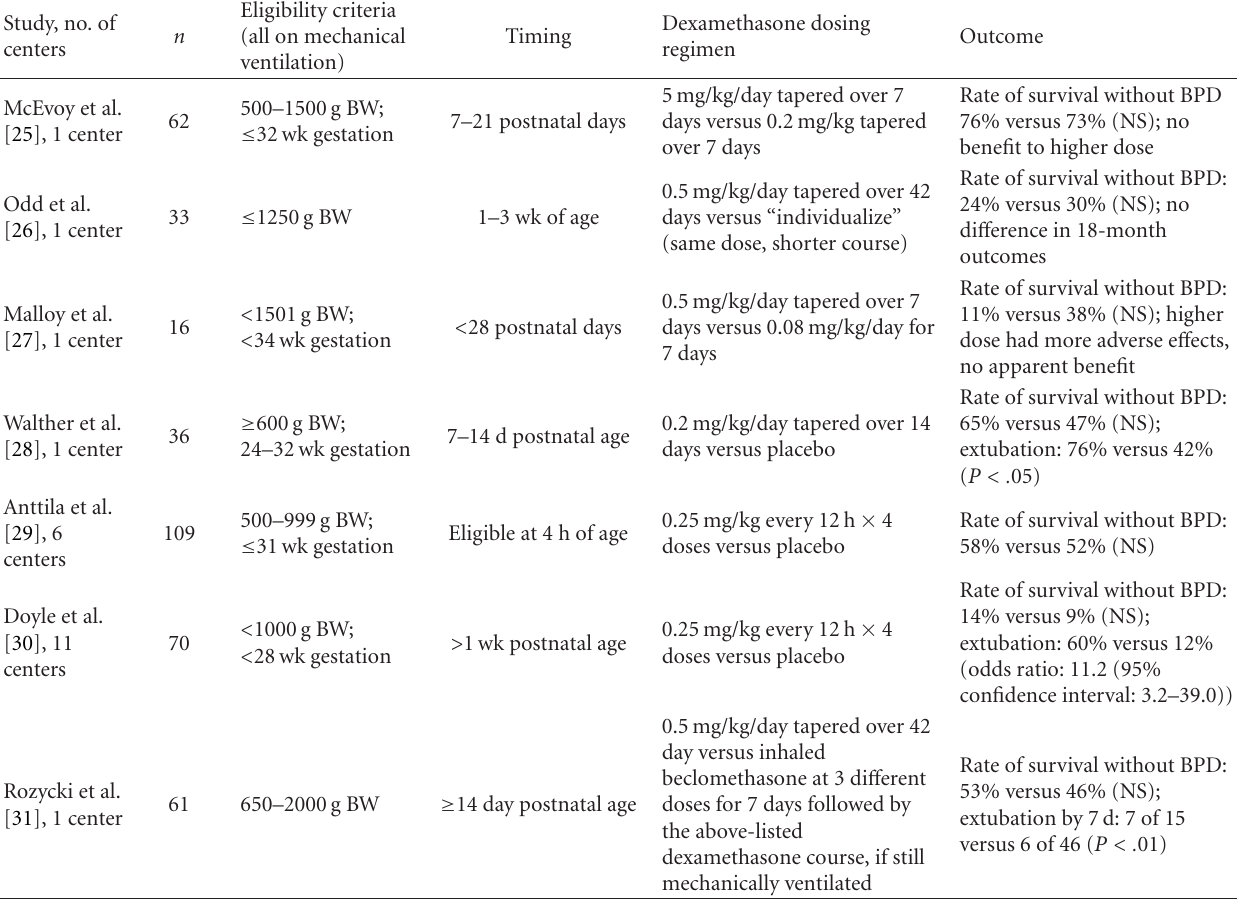
Table 1: RCTs of dexamethasone to prevent or treat BPD reported since